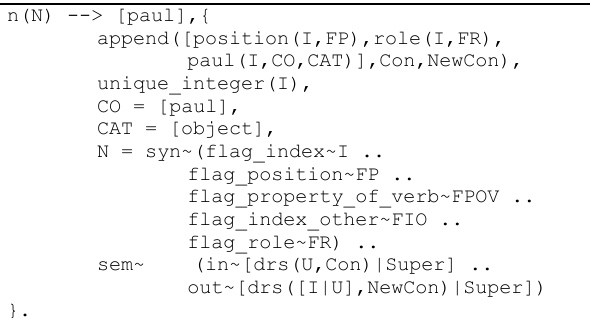
Figure 8. Describe proper noun “Paul” (example 14) in group D based on framework